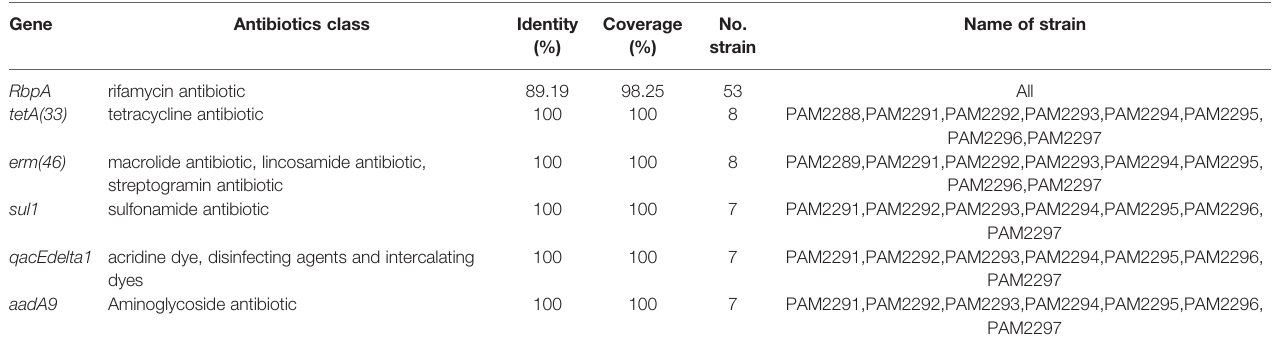
TABLE 1 | Distribution of antimicrobial resistance gene of R. equi . Gene Antibiotics class Identity